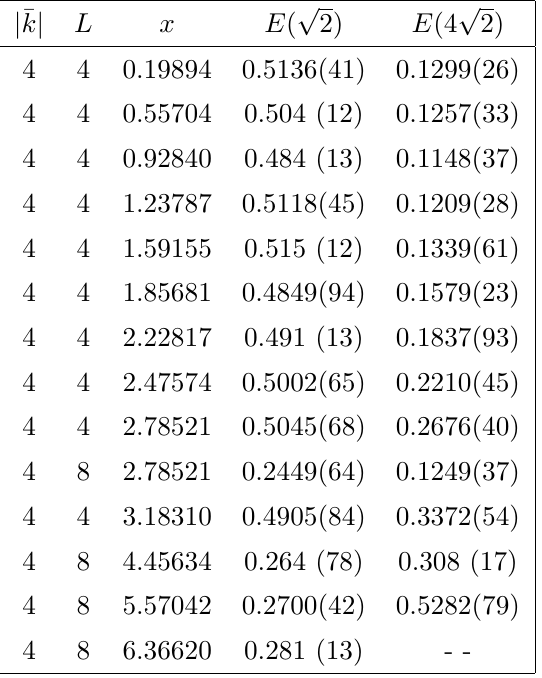
Table 17. SU(17) torelon energies (in lattice units)